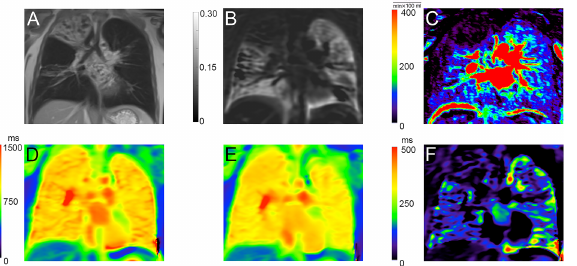
Fig 5. Incidentally discovered consolidation in the right upper lobe in a CF patient. A: T2-weighted; B: Fractional ventilationmap; C: Calculatedperfusionmap; D: Room air T1 map; E: Oxygen enhanced T1 map; F: Delta T1